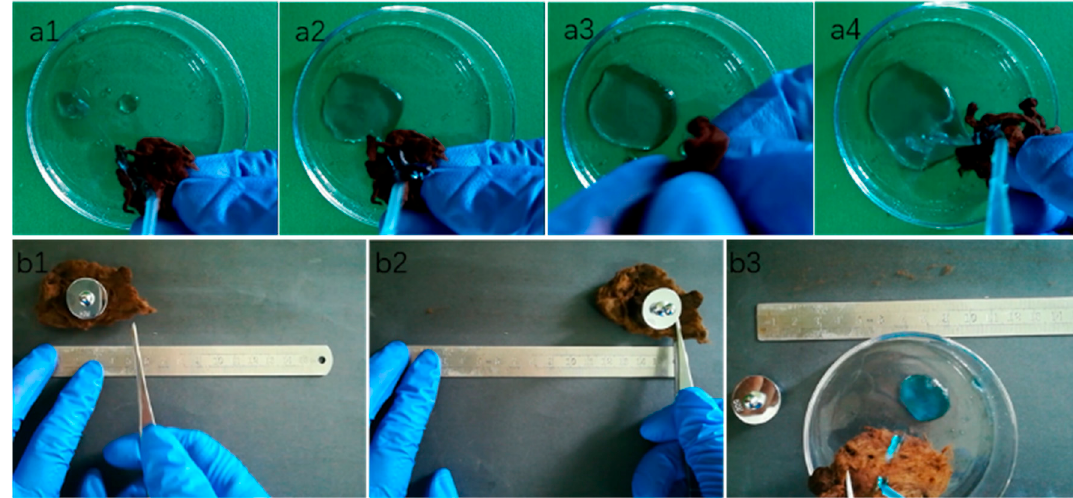
Figure 9. ( a ) Optical pictures demonstrating the method of the finger-wipe test of the as-prepared cotton fabrics; ( b ) optical pictures demonstrating one cycle of the sandpaper-abrasion test of the as-prepared cotton fabrics.